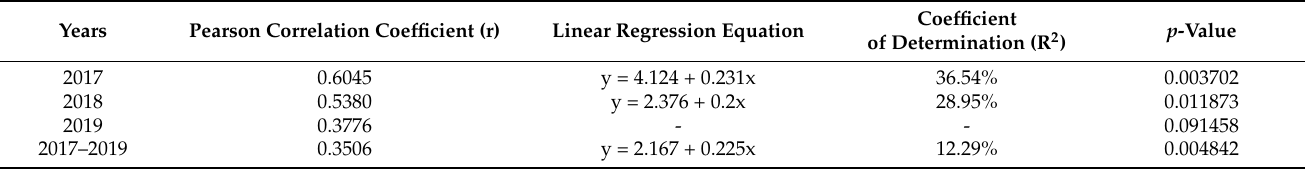
Table 10. Linear relationships between grain yield and nitrogen content in maize leaf blades at BBCH 65.